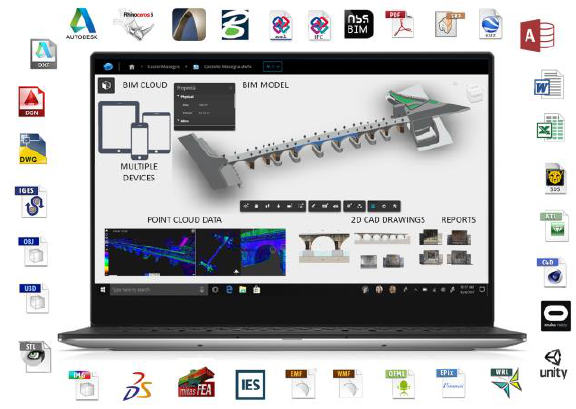
Figure 8. Azzone Visconti bridge's BIM